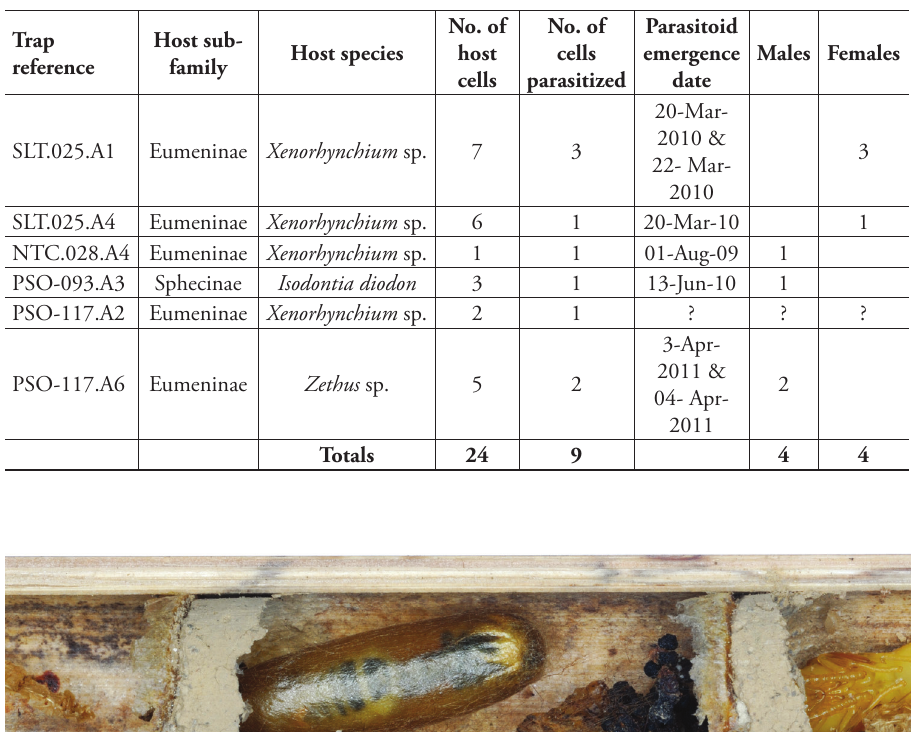
table 2. Contents of each trap.